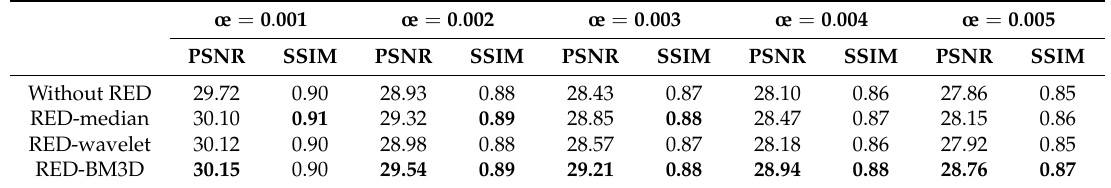
Table 1. PSNR(dB) and structure similarity (SSIM) of the proposed algorithm with different denoisers and varying amounts of Gaussian noise.